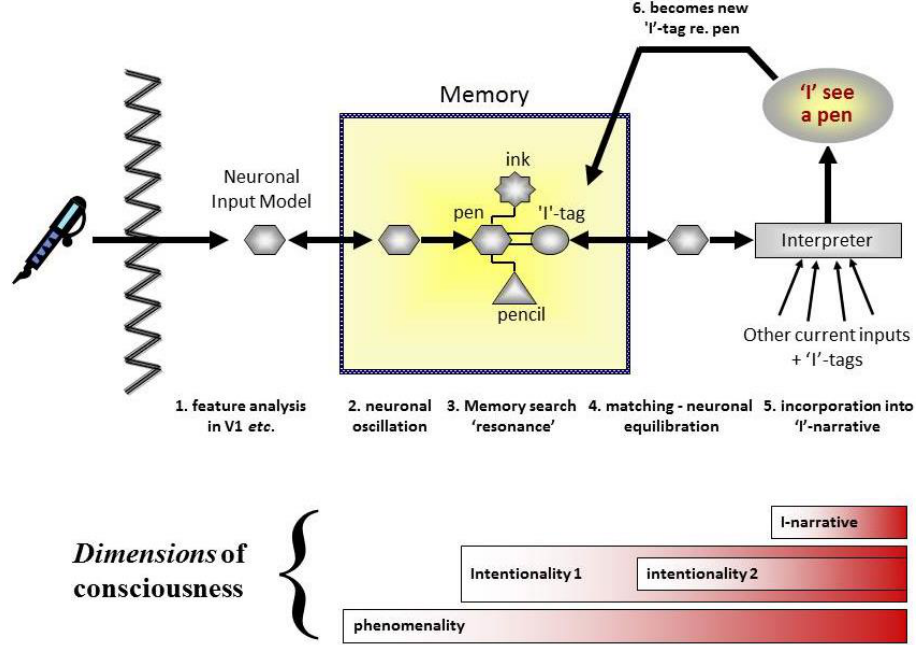
Figure 2. Dimensions of